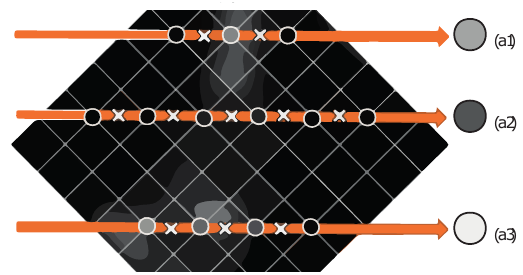
Figure 7. Representation of how the voxels are sampled by the raycast algorithm using the X-Ray model: voxel values are accumulated along the rays.